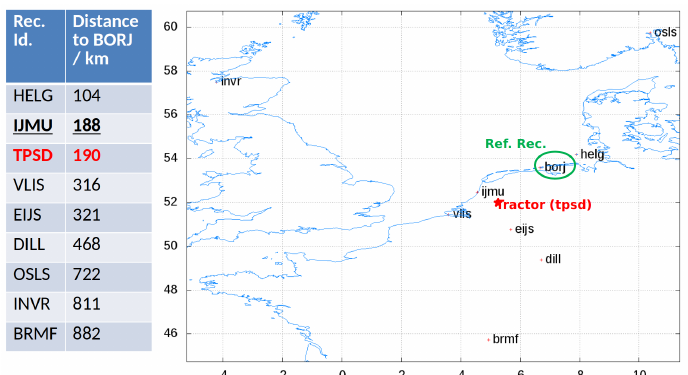
Figure 9. Right : Figure containing the location of the spraying tractor (TPSD) vs. the reference (BORJ) and permanent WARTK receivers (the remaining ones, excepting IJMU); Left : the table of distances to